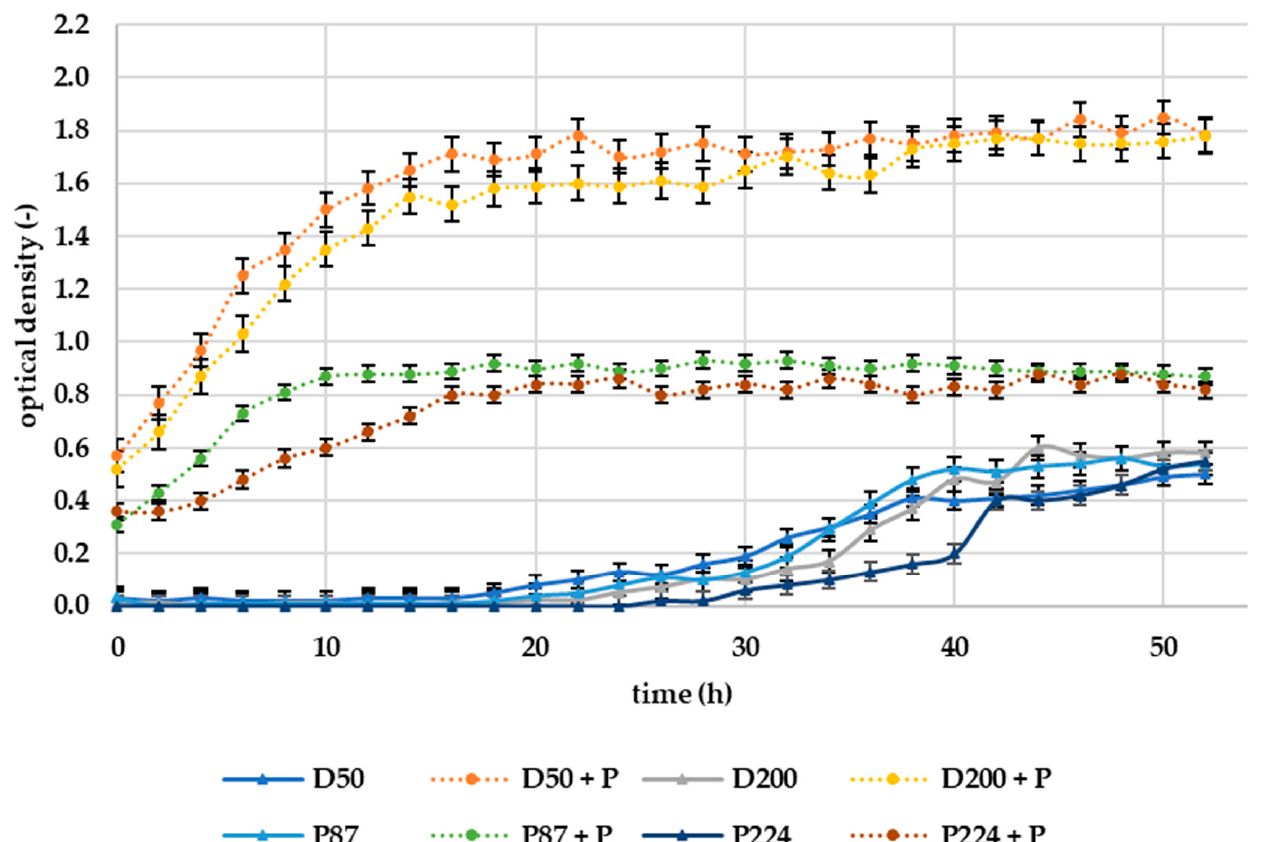
Figure 8. Effect of bacteriophages (+P) on growth curves of D. dianthicola (D50, D200) and P. carotovorum (P87, P224), in vitro experiment in liquid broth; +P–phage treated; markers represent the moving means and the error bars represent the standard deviations.